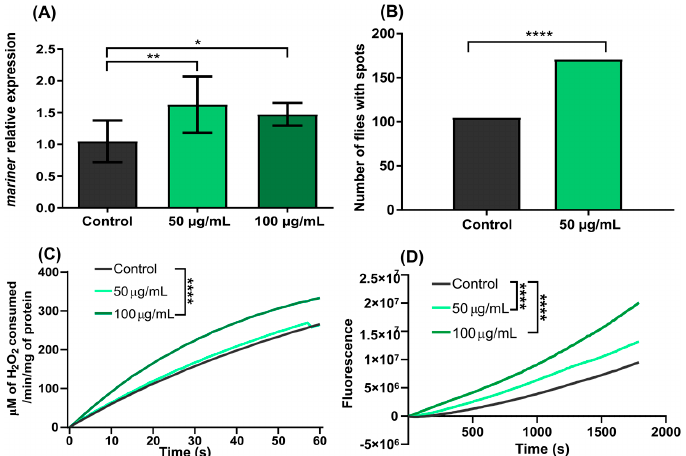
Figure 2. Effects of cisplatin in D. simulans w pch . ( A ) Relative transcriptional expression of the mariner TE in flies exposed to 50 and 100 µg/mL cisplatin. ( B ) Number of flies with red spots in the eyes after chronic exposure to 50 µg/mL cisplatin. ( C ) Monitoring of catalase activity in fly protein extracts, after 24 h of exposure to 50 or 100 µg/mL cisplatin. ( D ) Monitoring of ROS content in fly protein extracts, after 24 h of exposure to 50 or 100 µg/mL cisplatin. Data were analyzed by two-way ANOVA, followed by Tukey’s post hoc test. * Mean values are significantly different compared to Control (* = p < 0.05; ** = p < 0.001; **** = p < 0.0001).